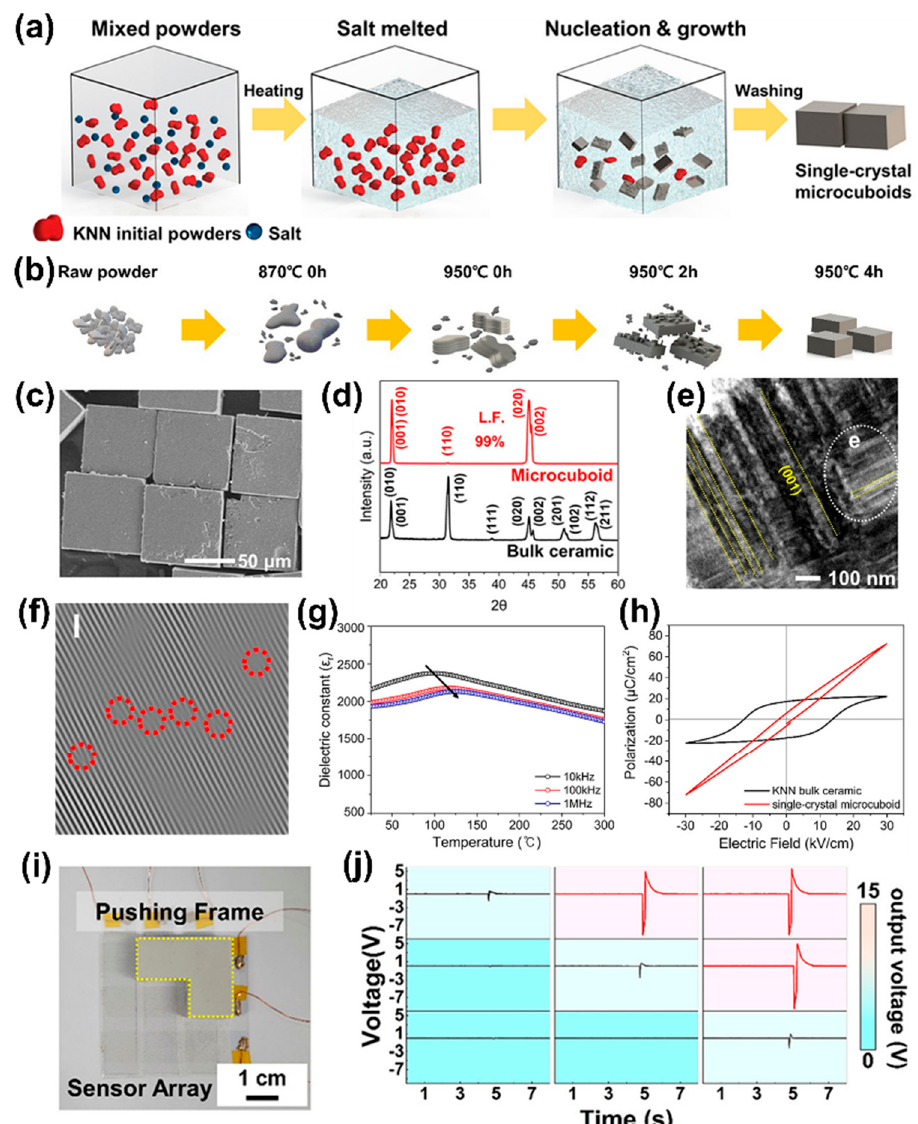
Figure 6. ( a ) Schematics for the synthesis process of KNN single − crystal micro − cuboids by the molten salt method. ( b ) Schematic diagram of the morphological evolution from raw powders to 3D micro − cuboids during the synthesis process. ( c ) SEM image of micro − cuboids. ( d ) X − ray diffraction pattern of micro − cuboids and bulk ceramic sample. ( e ) TEM image of (001) domain wall. ( f ) IFFT images showing dislocations (red dotted circle) along (001) domain wall. ( g ) Temperature variation of dielectric constant ( ε r ) of the KNN micro − cuboids at different frequencies. ( h ) Polarization − electric field (P-E) hysteresis loops of the single − crystal KNN micro − cuboids and KNN bulk ceramic sample measured at 1 kHz and room temperature. ( i ) Photograph of fabricated transparent, flexible KNN pressure sensor. ( j ) Generated output voltage signals from each sensing unit with color code mapping image by applied pressure. Reproduced with permission [95].